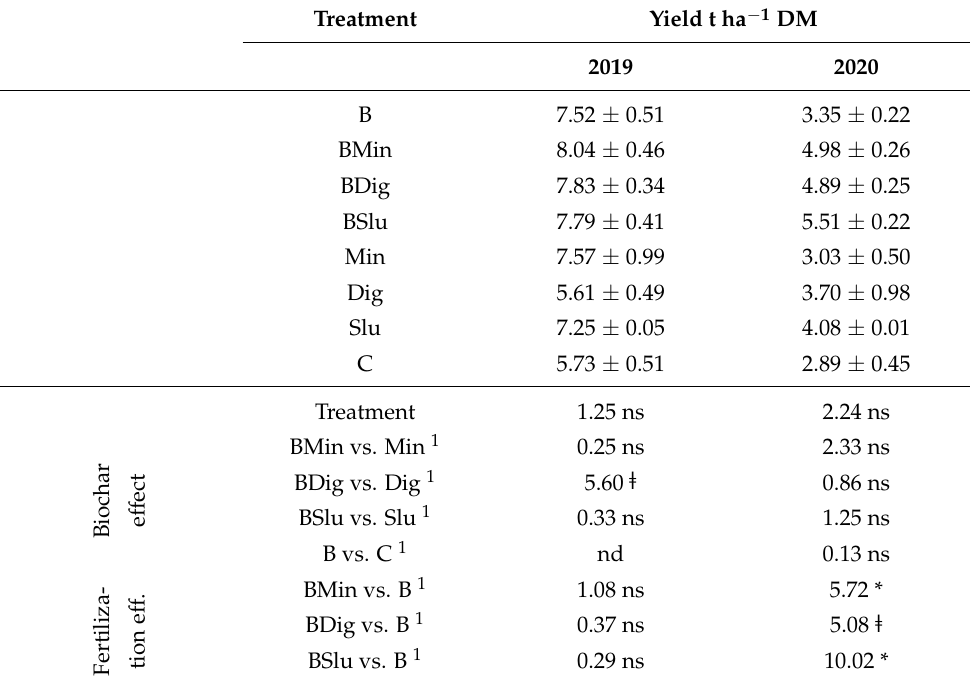
Table 5. Italian ryegrass yield in the two productive cycles 2018–19 and 2019–20; mean values and SE; ANOVA results. The crop was not fertilized; the treatments applied to the previous silage maize culture are indicated.